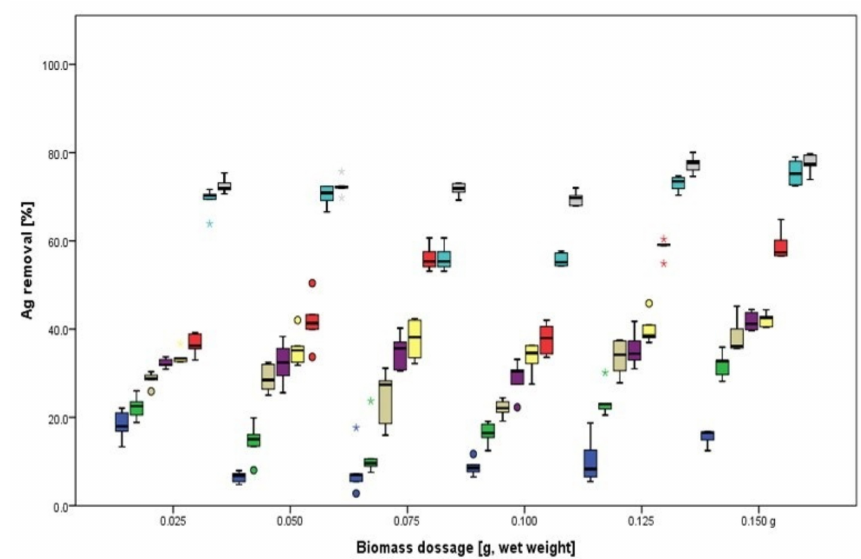
Figure 14. Ag removal by different quantities (wet weight) of Cladosporium cladosporioides pellets and at different contact times. (cid:4) : 1 h; (cid:4) : 2 h; (cid:4) : 3 h; (cid:4) : 4 h; (cid:4) : 5 h; (cid:4) : 6 h; (cid:4) : 12 h; (cid:4) : 24 h.